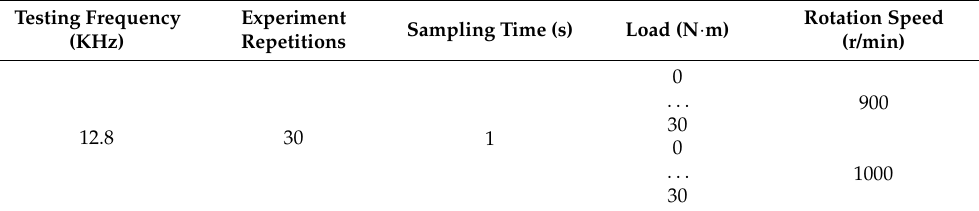
Table 1. Experimental gear